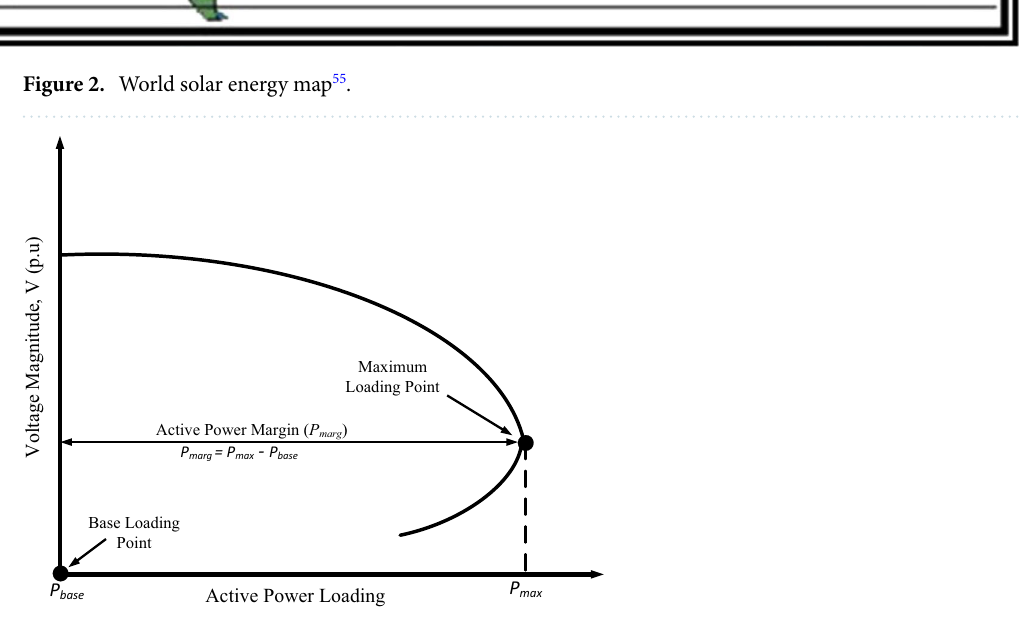
Figure 3. P–V curve showing the active power